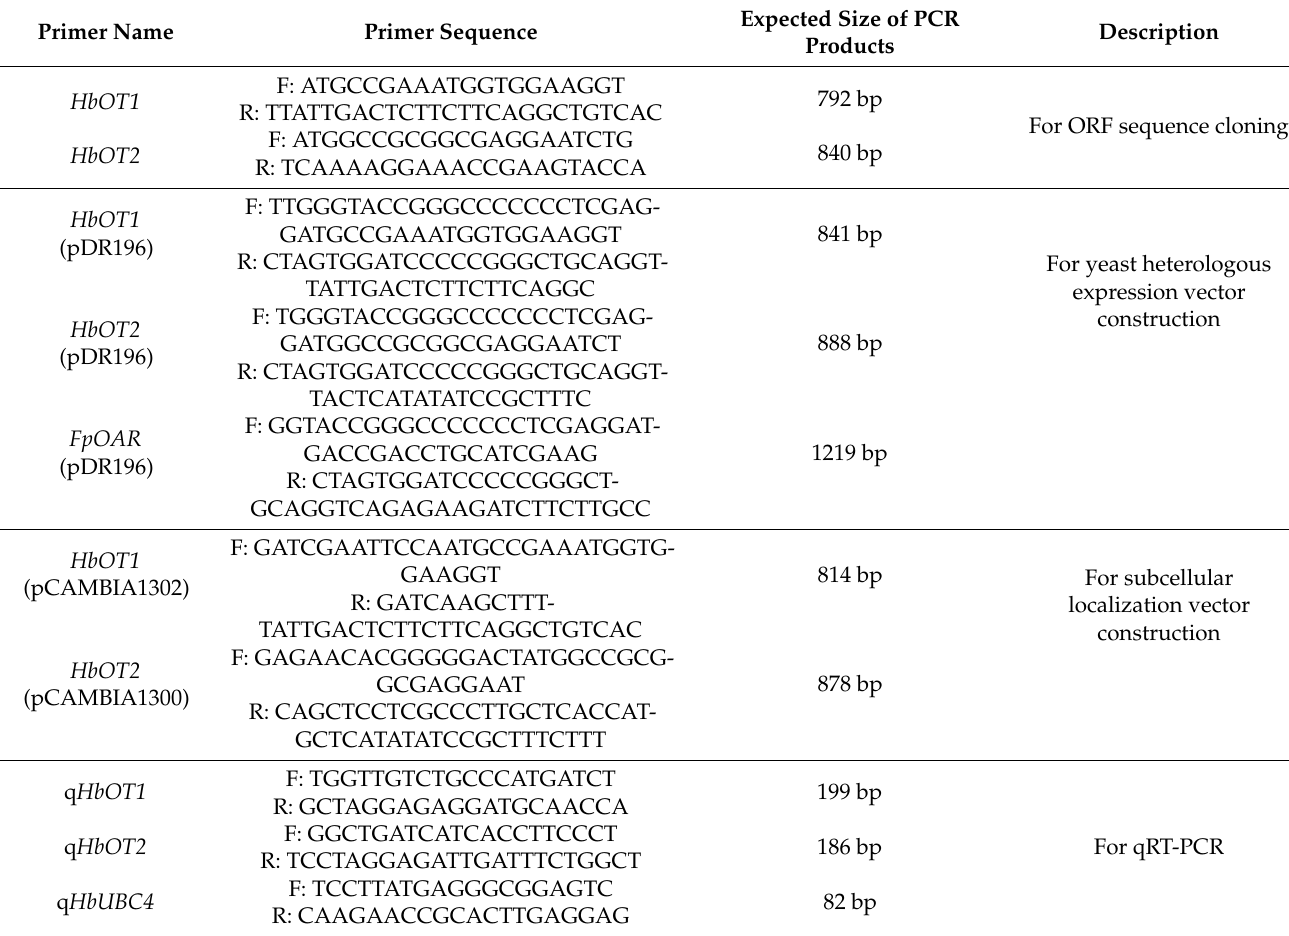
Table 1. Primers used in the